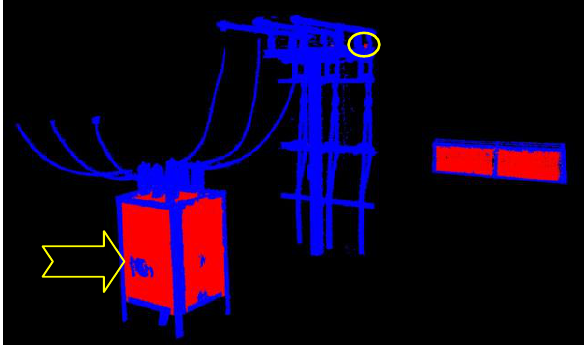
Figure 9. Segmentation results of the proposed method using Leica Figure 10. The segmentation results on circuit breakers obtained by the proposed method using Faro subset